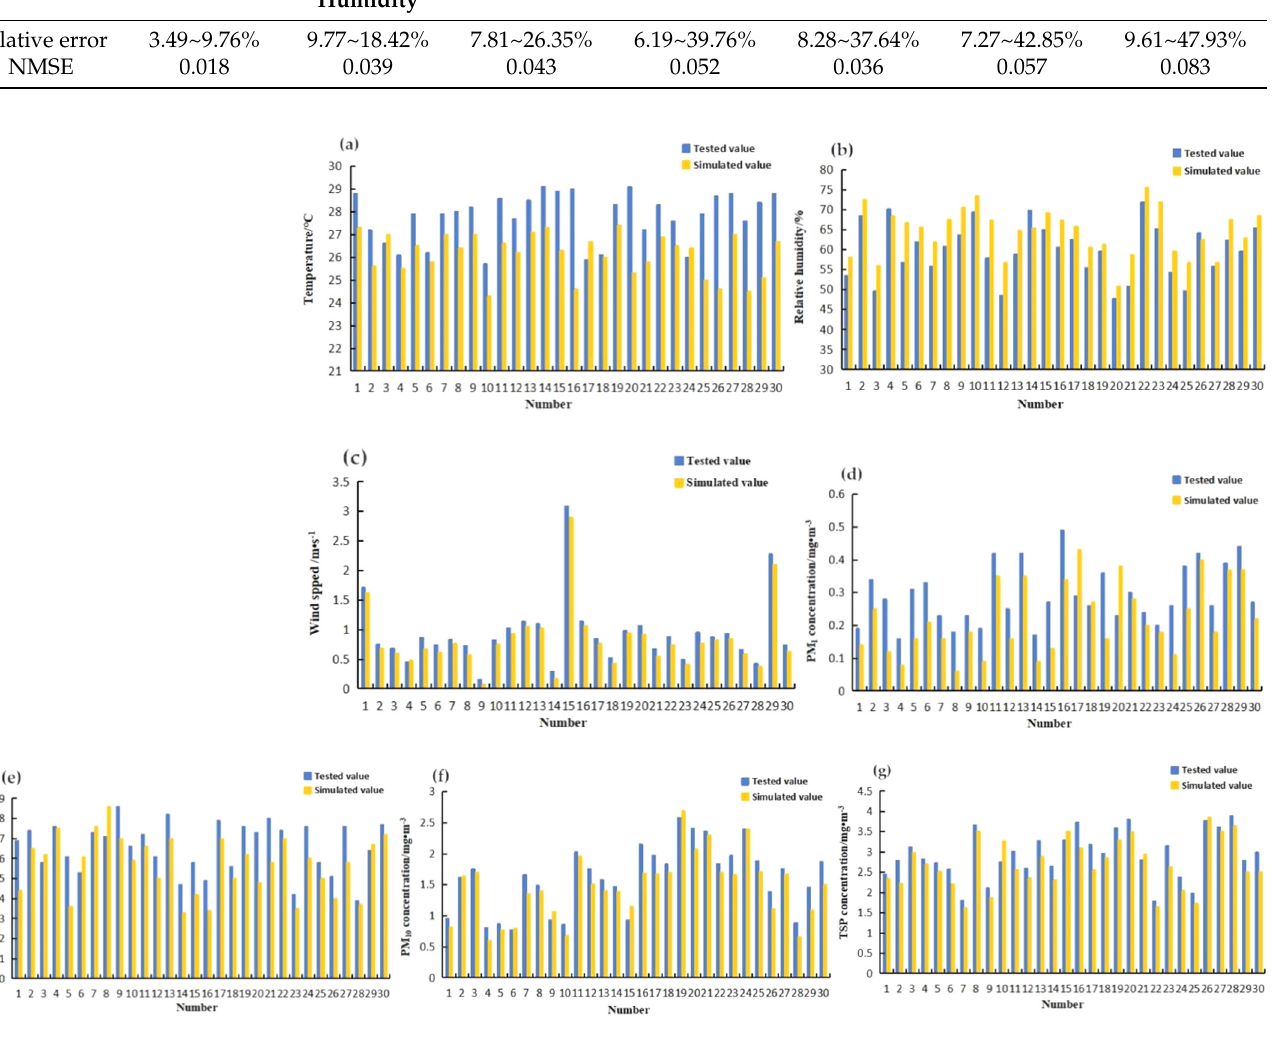
Figure 3. Measured value compared with simulated value: ( a ) temperature; ( b ) relative humidity; ( c ) wind speed; ( d ) PM 1 ; ( e ) PM 2.5 ; ( f ) PM 10 ; and ( g ) TSP (inside).